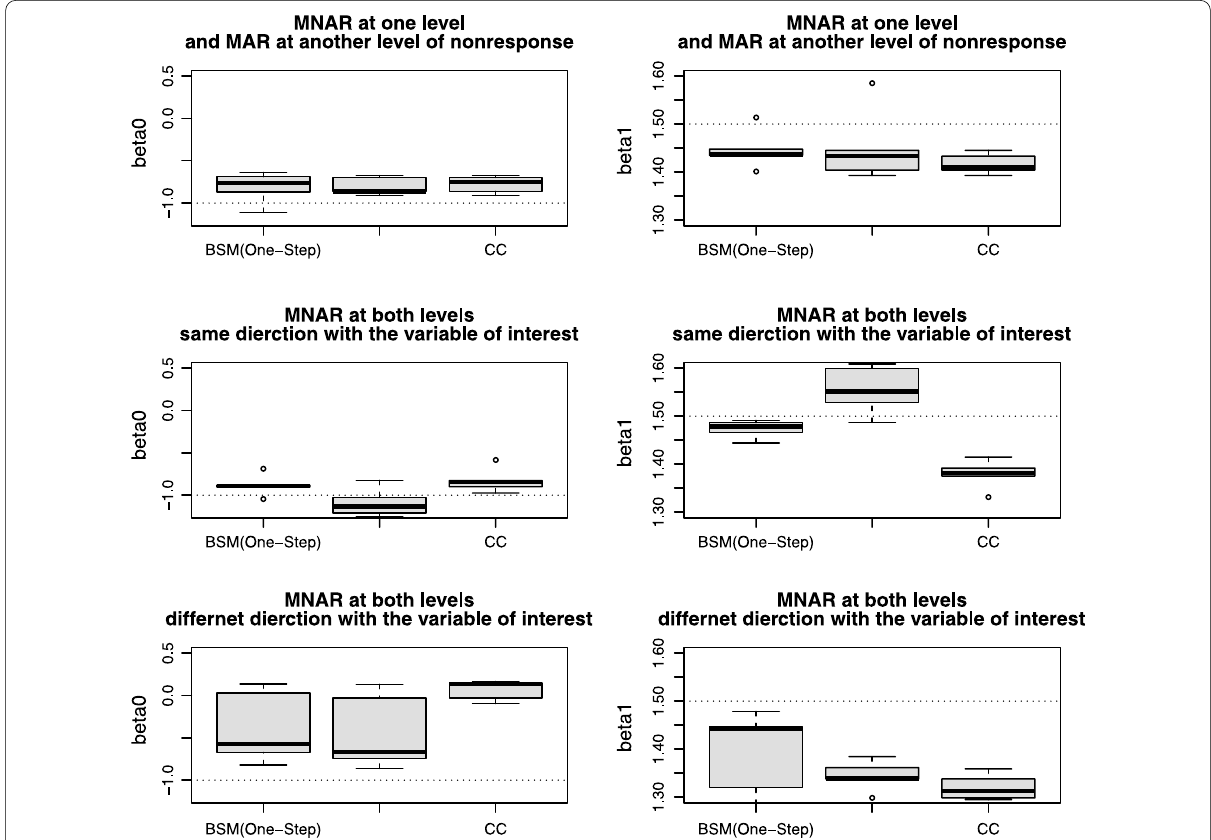
Fig. 2 Boxplots of the estimated regression coefficients of β 0 and β 1 with t distribution assumption from 500 simulation runs. Methods are the